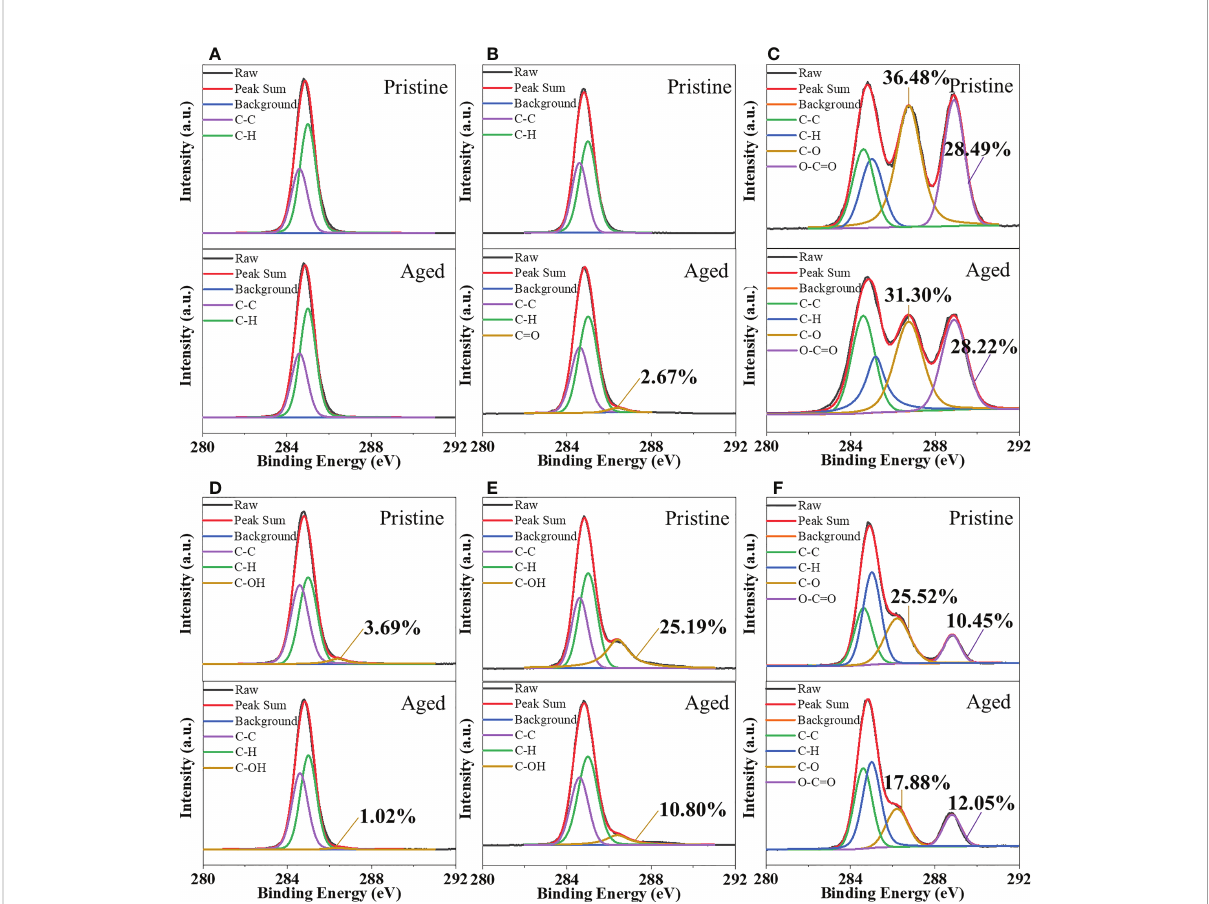
FIGURE 4 C1sXPSspectraof thepristineandagedMPstreatedby 2monthsof UVirradiationinnatural seawater. (A) PE, (B) PP, (C) PLA, (D) PE/TPS, (E) PP/TPS, and (F) PLA/PBAT/TPS.PE, polyethylene;PP,polypropylene;PLA, polylacticacid;PE/TPS, polyethylene/thermoplasticstarchblends;PP/TPS, polypropylene/ thermoplasticstarchblends;andPLA/PBAT/TPS,polylacticacid/poly (butyleneadipate- co